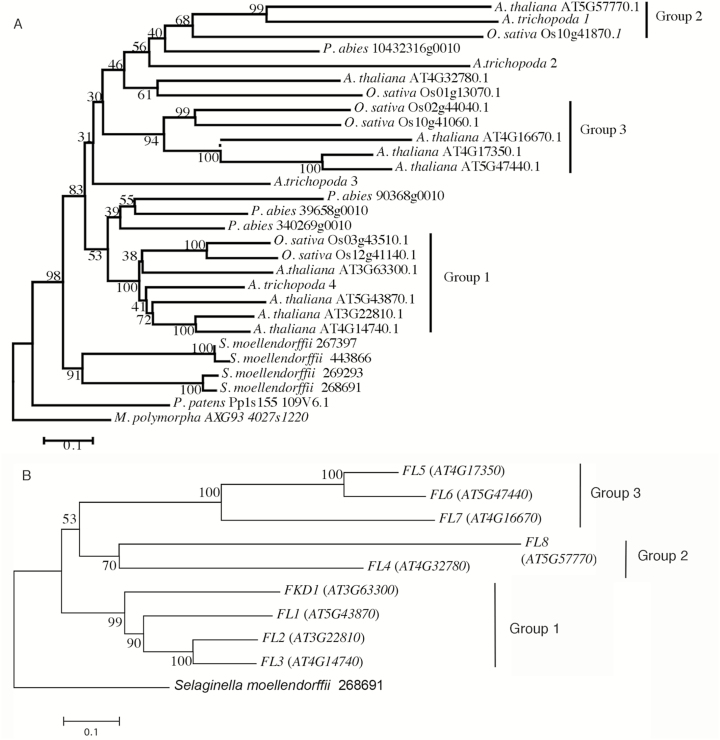
Phylogenetic tree of (A) DUF828 domain sequences from diverse species in the plant kingdom and (B) DUF828-encoding genes (FL gene family) in Arabidopsis thaliana. Phylogenetic tree of proteins from representative species Marchantia polymorpha subsp Polymorpha, Physcomitrella patens, Selaginella moellendorffii, Picea abies, Amborella trichopoda, Oryza sativa, and Arabidopsis thaliana. Bootstrap values over 500 replicates are given at each branch. Strongly supported Angiosperm groups (bootstrap value >75) are indicated as groups 1, 2, and 3. (B) Phylogenetic tree of FL gene family (At3g63300, FKD1; At5g43870, FL1; At3g22810, FL2; At4g14740, FL3; At4g32780, FL4; At4g17350, FL5; At5g474400, FL6; At4g16670, FL7, and At5g57770, FL8) in A. thaliana. Groups 1, 2, and 3 correspond to those in (A).